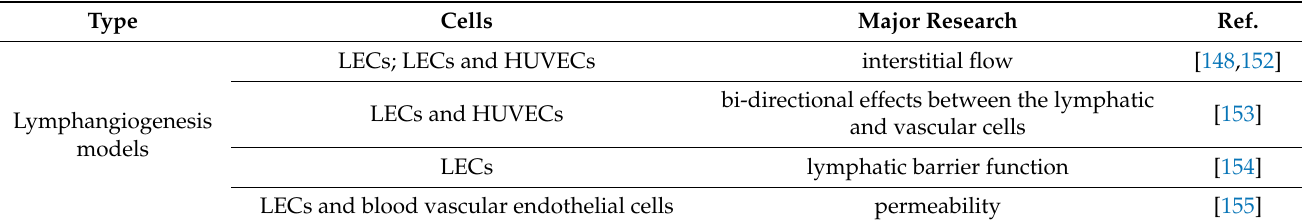
Table 2. In vitro reconstitution of lymphatic vessel